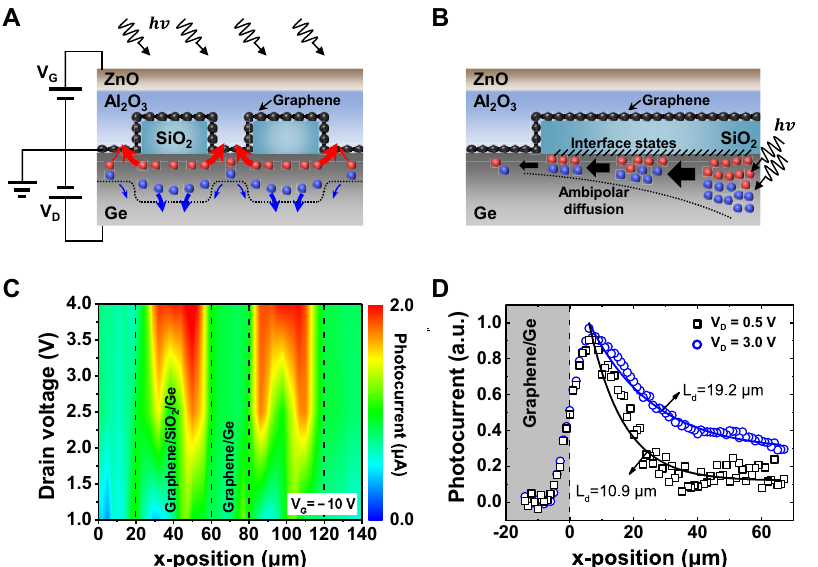
Figure 6: (A) Schematic diagram of the carrier generation, extraction, and collection mechanisms in a split active junction photodetector under illumination. Blue and red circle: photogenerated electron and hole in Ge, respectively. (B) Schematic diagram of the ambipolar diffusion along the SiO 2 /Ge interface. The interface states are presented at the interface between SiO 2 and Ge. (C) Photocurrent map as a function of V D from 1 to 4 V under V G = − 10 V at incident light power of 10 μ W. Black dashed line: transition region. (D) Photocurrent decay pro fi leasafunctionoftheincidentlightpositioninthegraphene/SiO 2 /Geregionmeasuredat V D =0.5and3Vunder V G = − 10V.Solidlinesare a fi t to the data, and the diffusion lengths are 10.9 and 19.2 μ m at V D = 0.5 and 3 V,